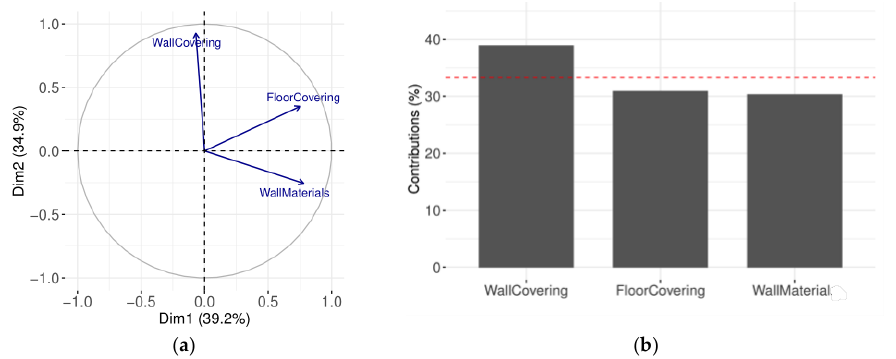
Figure 11. Results of the fourth PCA analysis : ( a ) the correlation circle and ( b ) percentage contribu- tions of the factors that formed the main components (see Table 1).